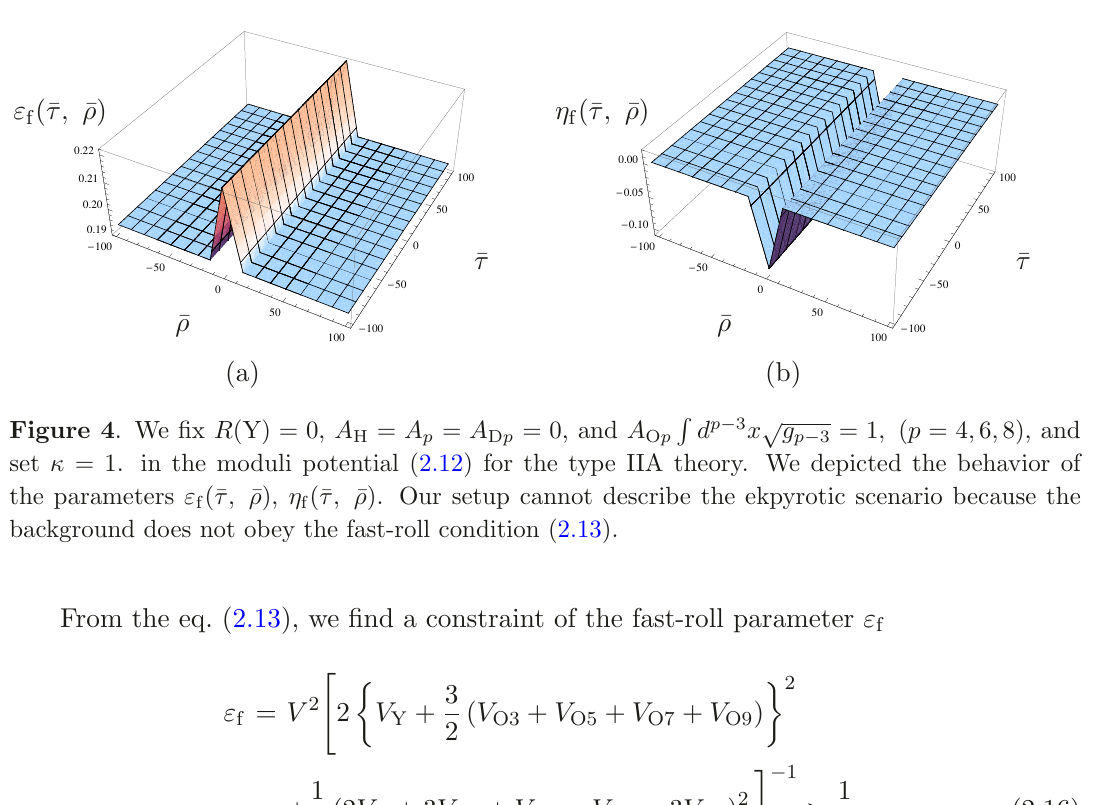
Figure 3 . The moduli potential V (¯ τ, ¯ ρ ) in the type IIA theory for the case of R (Y) = 0, A H = A p = A D p = 0, and A O p d p − 3 x √ g p − 3 = 1 , ( p = 4 , 6 , 8) is depicted. Fixing the four-dimensional gravitational constant as κ = 1, we obtain the negative potential. R